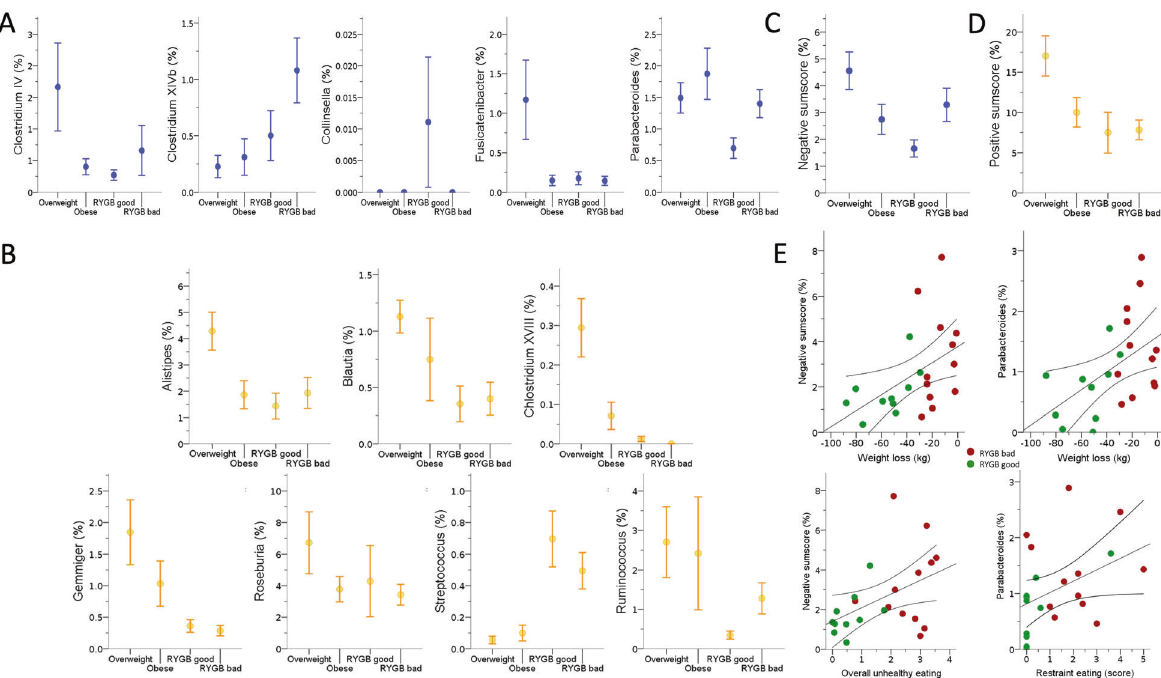
Fig. 6 Differences in relative bacterial genera abundance across groups of overweight, obese and post-RYGB adults in sample 2. For A inversely health-related (blue), B positively related genera (yellow), C negative (blue), and D positive sumscores of all related genera (yellow) detected in sample 1. E Correlation of negative genera sumscore and/or Parabacteroides abundance with eating behavior and/or weight loss after RYGB surgery (green: good responders; red: bad responders). RYGB, Roux-en-Y gastric bypass. Mean + SD.